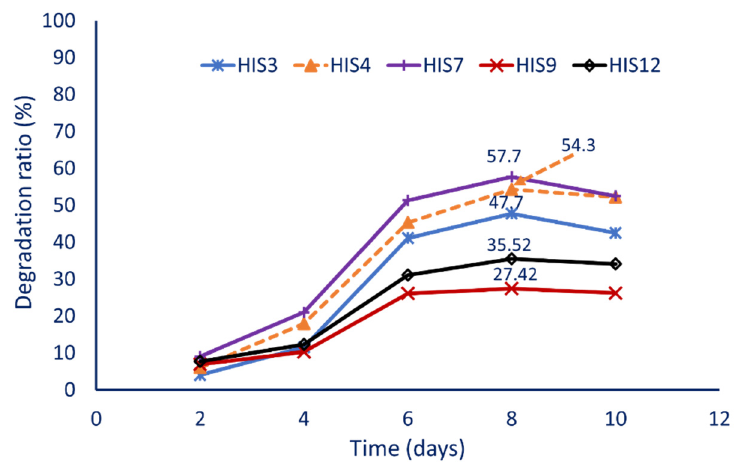
Figure 1. The quantitative screening of five bacterial isolates to degrade the cypermethrin at a concentration of 2500 ppm at different interval times.